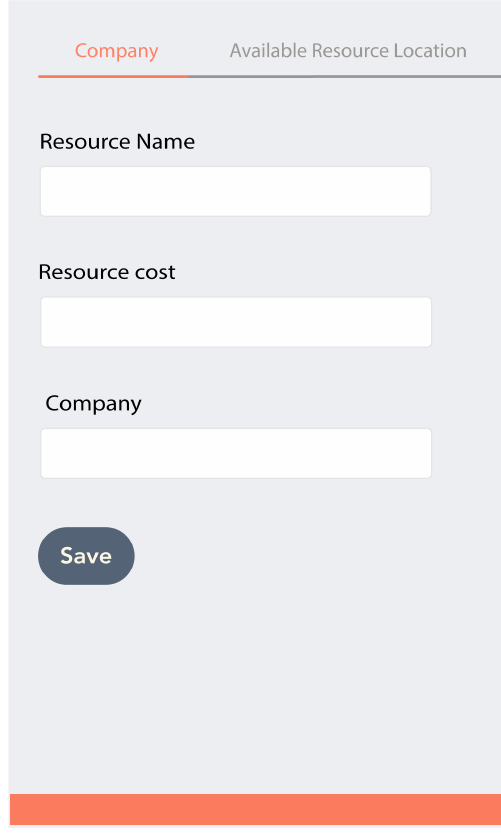
Figure 20. Resource publishing.